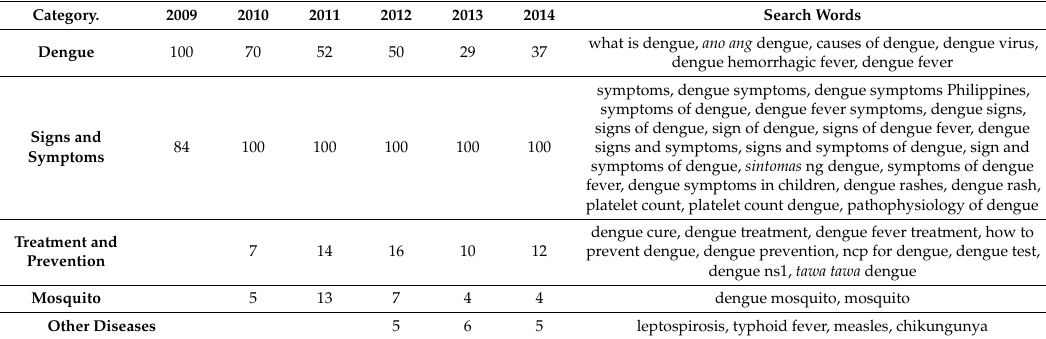
Table 2. Thematic categories of top search queries related to dengue from 2009–2014 in Metropolitan Manila. Values from 2009–2014 are percentages (%) based on the overall GDT values of each category per